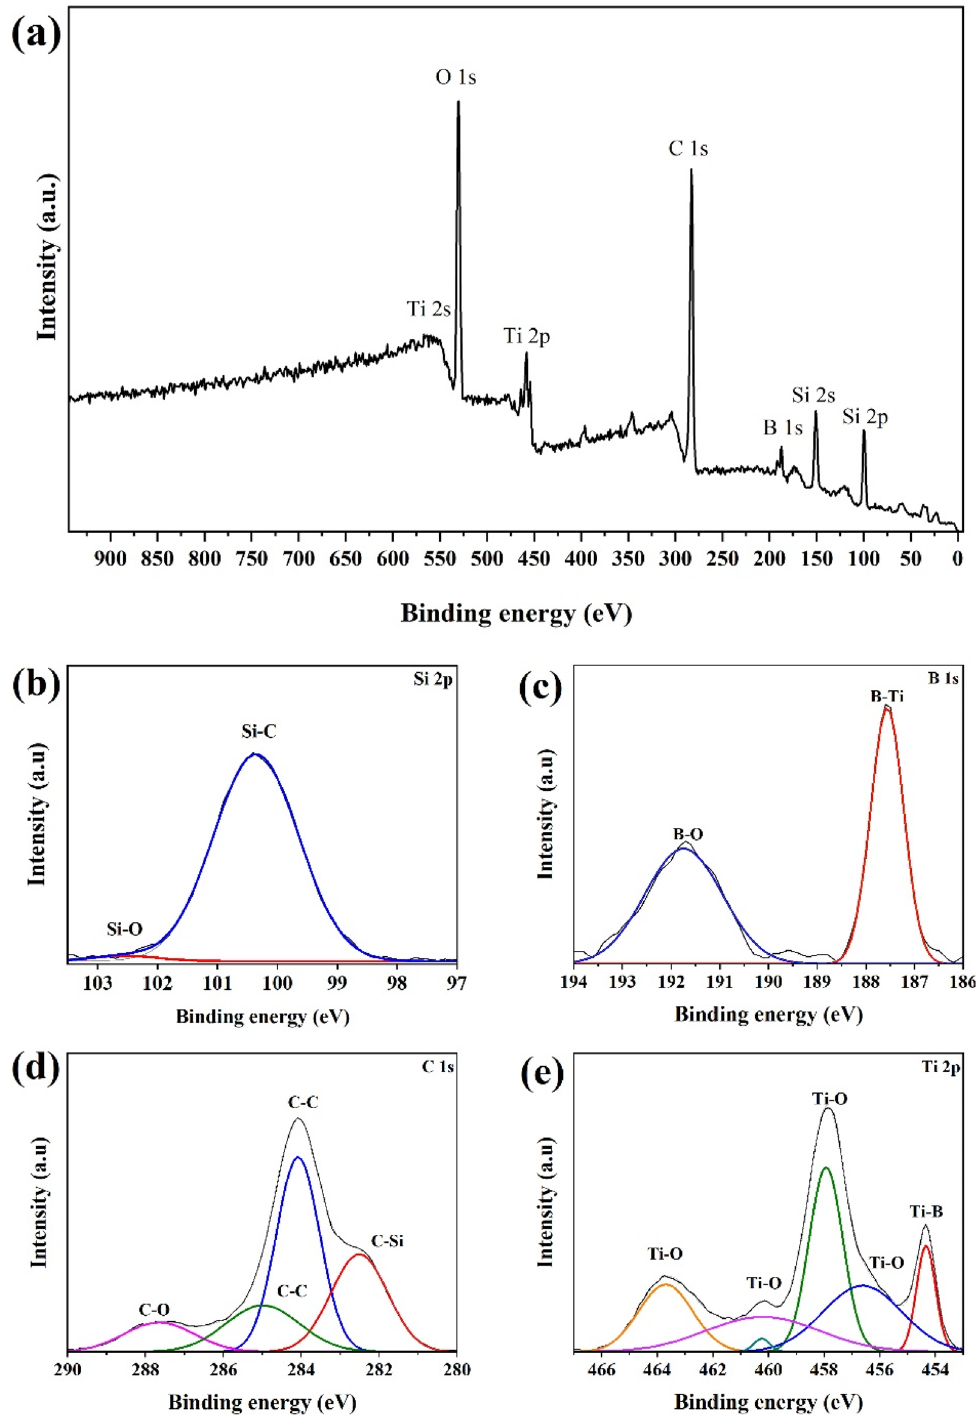
Figure 3. XPS analysis of C f -incorporated TiB 2 –SiC composite ( a ) survey, ( b ) Si 2p, ( c ) B 1s, ( d ) C 1s, and ( e ) Ti